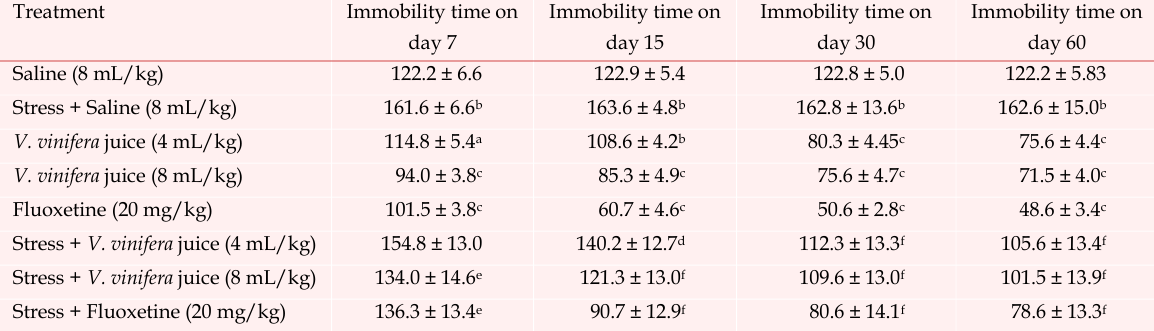
Effect of Vitis vinifera juice on immobility time of mice in forced swimming test